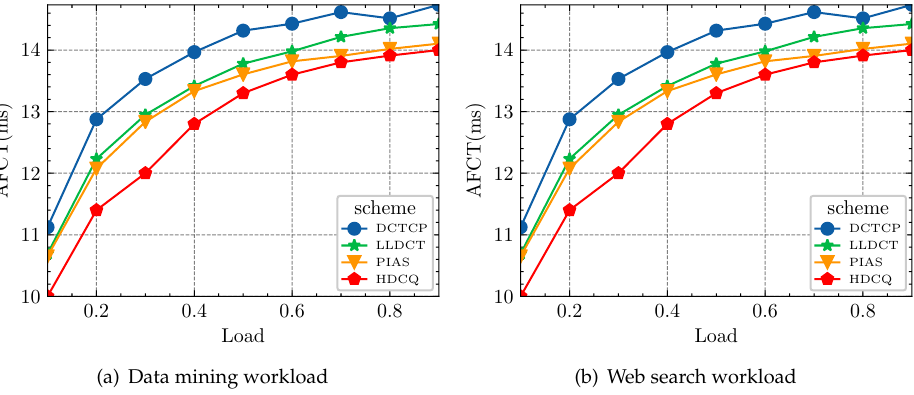
Figure 10. Overall average flow completion times for both